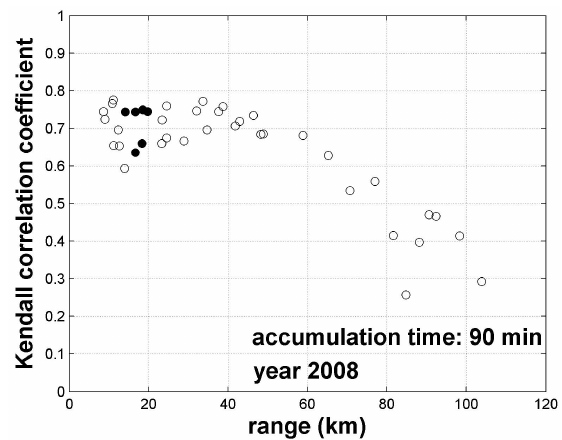
Fig. 3. Trend against range of the Kendall coefficient before radar calibration (with an accumulation time of 90 min) performed by using 2008 data. Black dots refer to the rain gauges chosen for radar